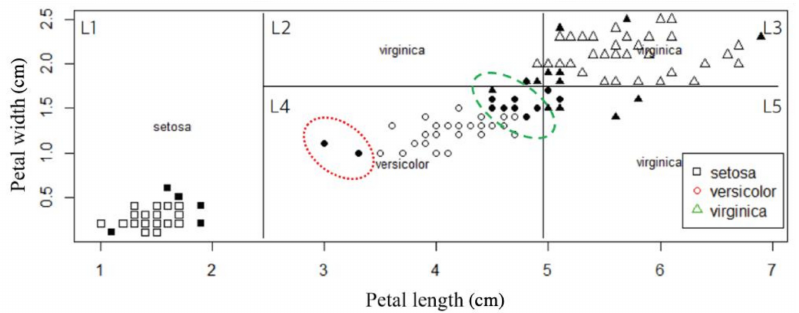
Figure 1. The construction of a decision tree and SVMs for the iris data shows the boundaries and support vectors (the filled shapes). The support vectors in the regions are located far away from the majority-class